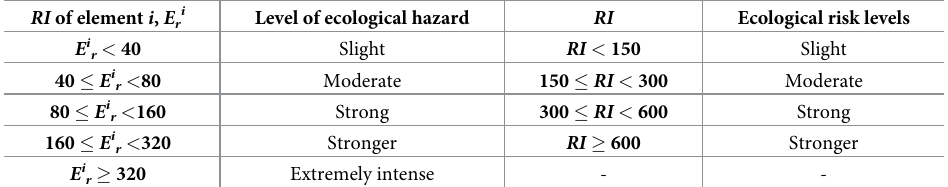
Table 3. E ri and RI classification